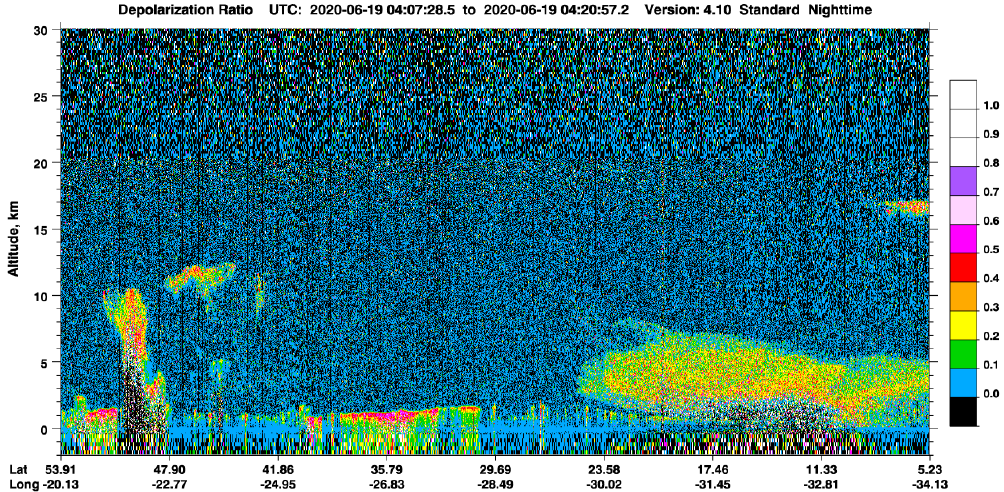
Figure 16. CALIPSO overpass above northeast Atlantic Ocean – depolarization ratio product (CALIPSO, 2021).